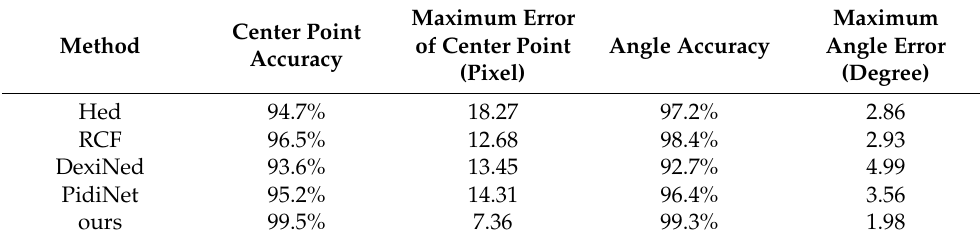
Table 4. Comparison of ablation experiments of different modules.